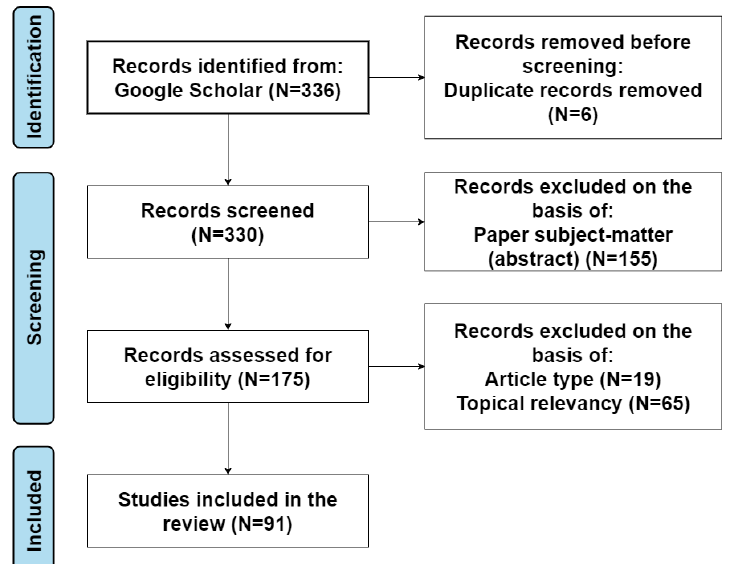
Figure 1. Summary of PRISMA flowchart of the article selection process for this review.